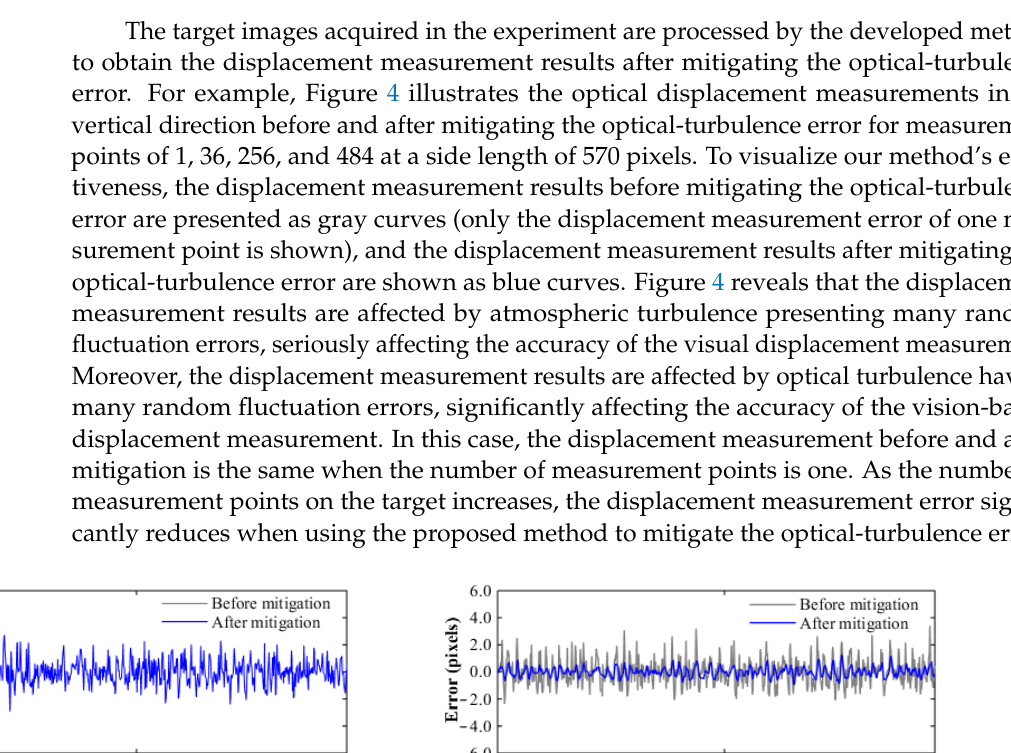
Figure 3. Target images under various numbers of measurement points affected by optical turbu- lence for a target side length of 285 pixels, Number of measurement points ( a ) 1, ( b ) 36, ( c ) 256, and ( d ) 484.